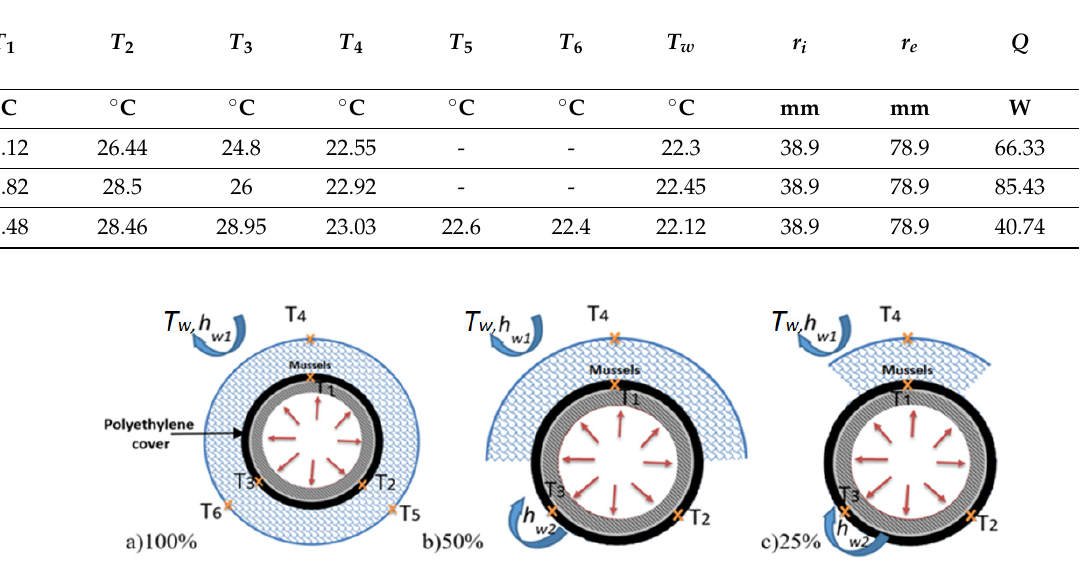
Figure 10. Various colonization distribution configurations around the heated covered polyethylene aluminum tube. ( a ) 100% colonization, ( b ) 50 % colonization and ( c ) 25% colonization. Where, T w is the temperature of the surrounding water, h w 1 and h w 2 is the heat transfer coefficient of the water around the mussels and the tube, respectively. T 1 , T 2 , T 3 are the temperatures of surface of the experimental tube. T 4 , T 5 , T 6 are the temperature of the external layer of